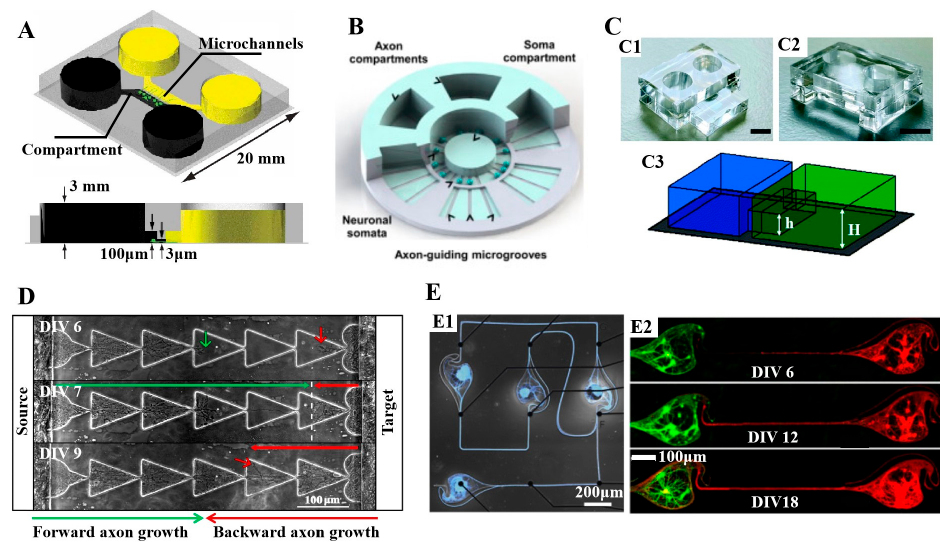
Figure 4. PDMS microfluidic devices with controlling synaptic growth channels. ( A ) Structure diagram of a microfluidic device capable of separating cell bodies and neurite [76]. Reproduced with permission from Taylor, Nature Methods; published by Nature, 2005. ( B ) A microfluidic device